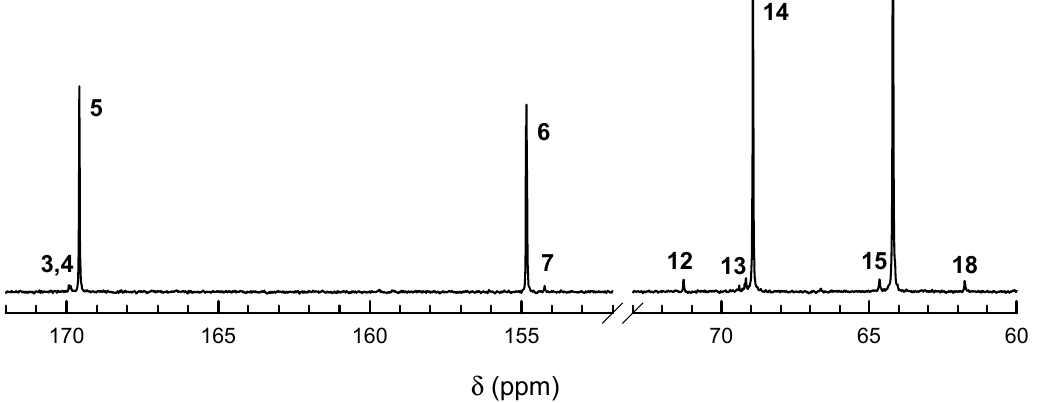
Figure 4. 13 C NMR spectra of Tmc / Lac copolymers prepared with R - Ini . Polymerization conditions: [ Lac ] 0 , [ Tmc ] 0 , [ R - Ini ] 0 = 1.2, 2, and 2 × 10 − 3 (+[ i PrOH] 0 = 4 × 10 − 3 ) mol · L − 1 , respectively. Time 3.81 × 10 6 s, conversion Lac = 92%, conversion Tmc = 99%. Note large contributions of signals of homo Lac and Tmc sequences, signals 13, and 15, respectively. Assignment of signals is given in Table 1.